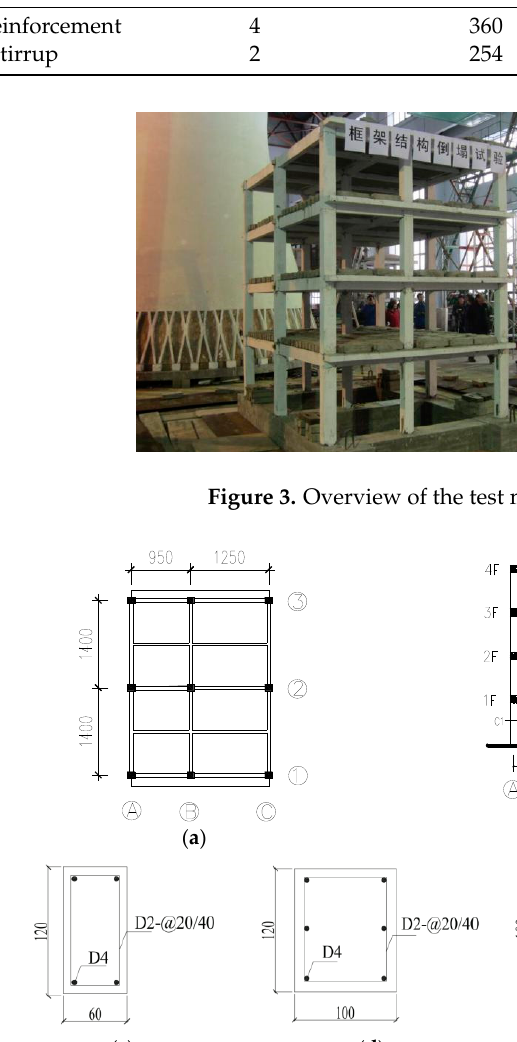
Figure 4. Construction information of the test model. ( a ) Plan; ( b ) Elevation; ( c ) Beam section; ( d )